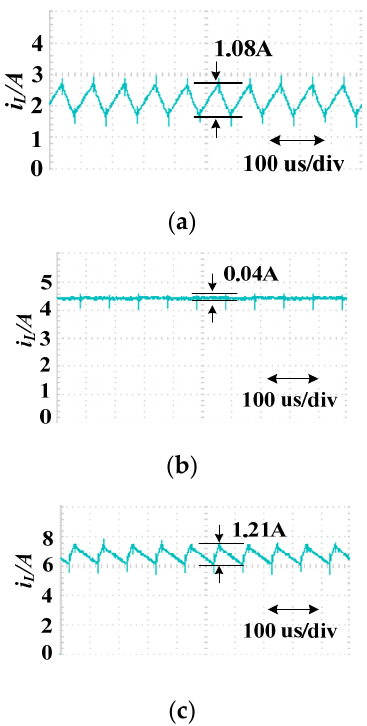
Figure 11. Steady state characteristics of series circuit.